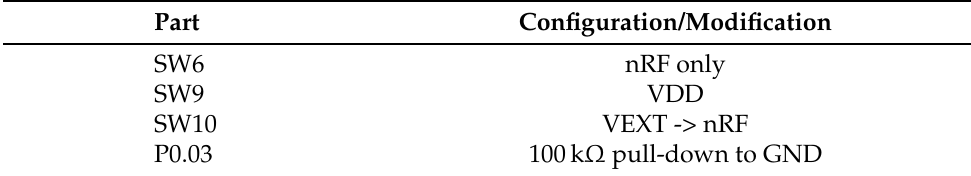
Table A2. Configuration and modification of the nRF52840 DK.